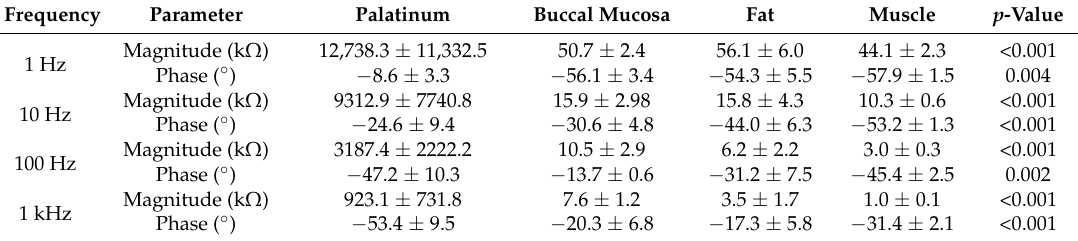
Table 1. Impedance magnitude and phase values (mean ± stdv) for each tissue type at seven discrete frequencies using the inner configuration. The p -value was calculated using the Kruskal-Wallis test. Frequency Parameter Palatinum Buccal Mucosa Fat